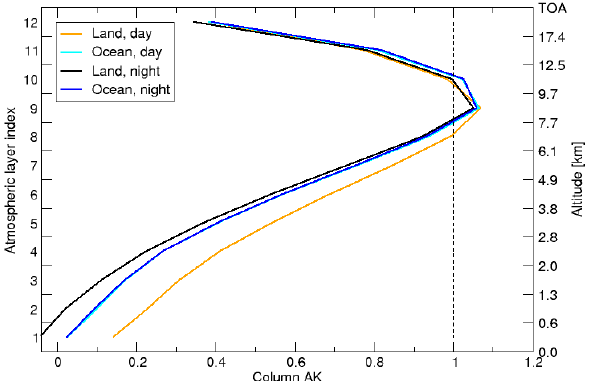
Figure 2. The average of all column averaging kernels in this study for different scenes and measurement times. Daytime and nighttime measurements over land are depicted as orange and black curves and over the ocean in dark blue and cyan curves,